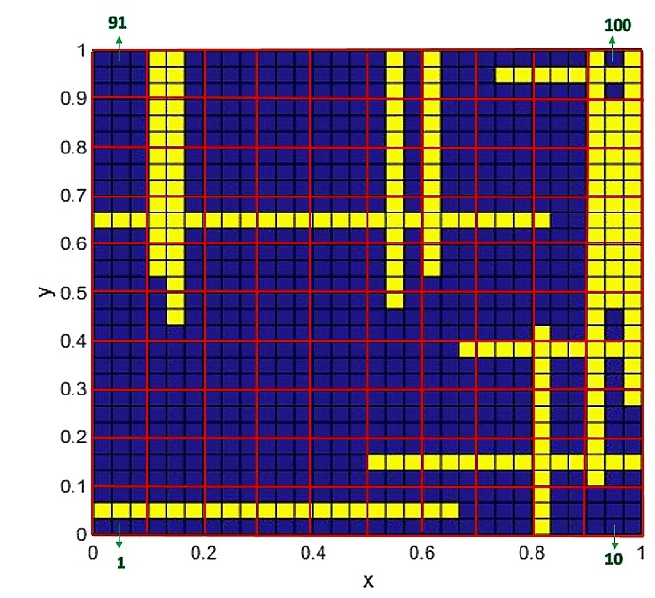
Figure 1. A typical permeability field of a fractured porous medium. The matrix permeability is assumed to be 4 mD. The fracture permeability is assumed to be 2000 mD. The fine grid squares represent the formation matrix (blue) in some cases and fractures (yellow) in other cases (selected randomly). The red lines define the coarse grid. Each coarse grid square contains nine fine-grid squares. There are fifteen fractures assigned to this porous